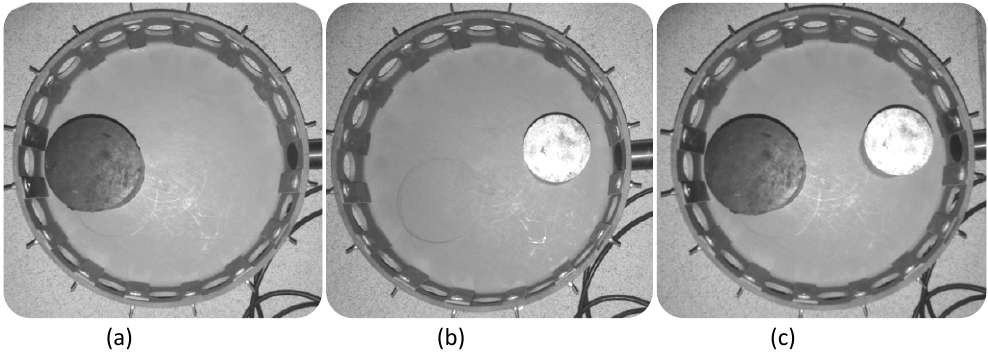
Figure 1: The phantom uses distilled water as medium and (a) insulator, (b) conductor, and (c) insulator-conductor